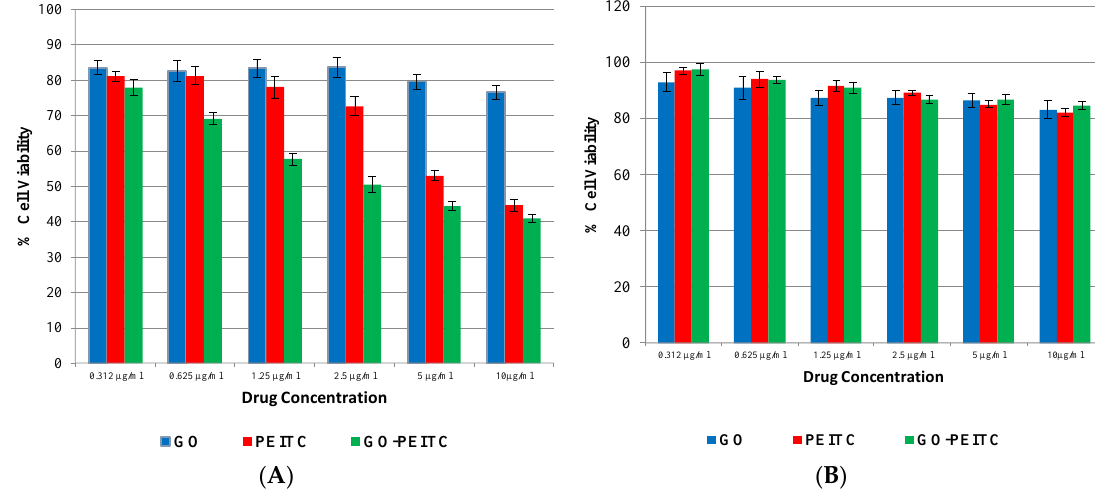
Figure 8. Effects of GO, PEITC and PEITC-loaded GO (GO-PEITC) (0–10 μg/mL) on viability of ( A ) HepG2 and ( B ) 3T3 cell line and the cell viability was measured by MTT assay (72 h). Data represented as mean ± SE of three independent experiments made in three replicates.